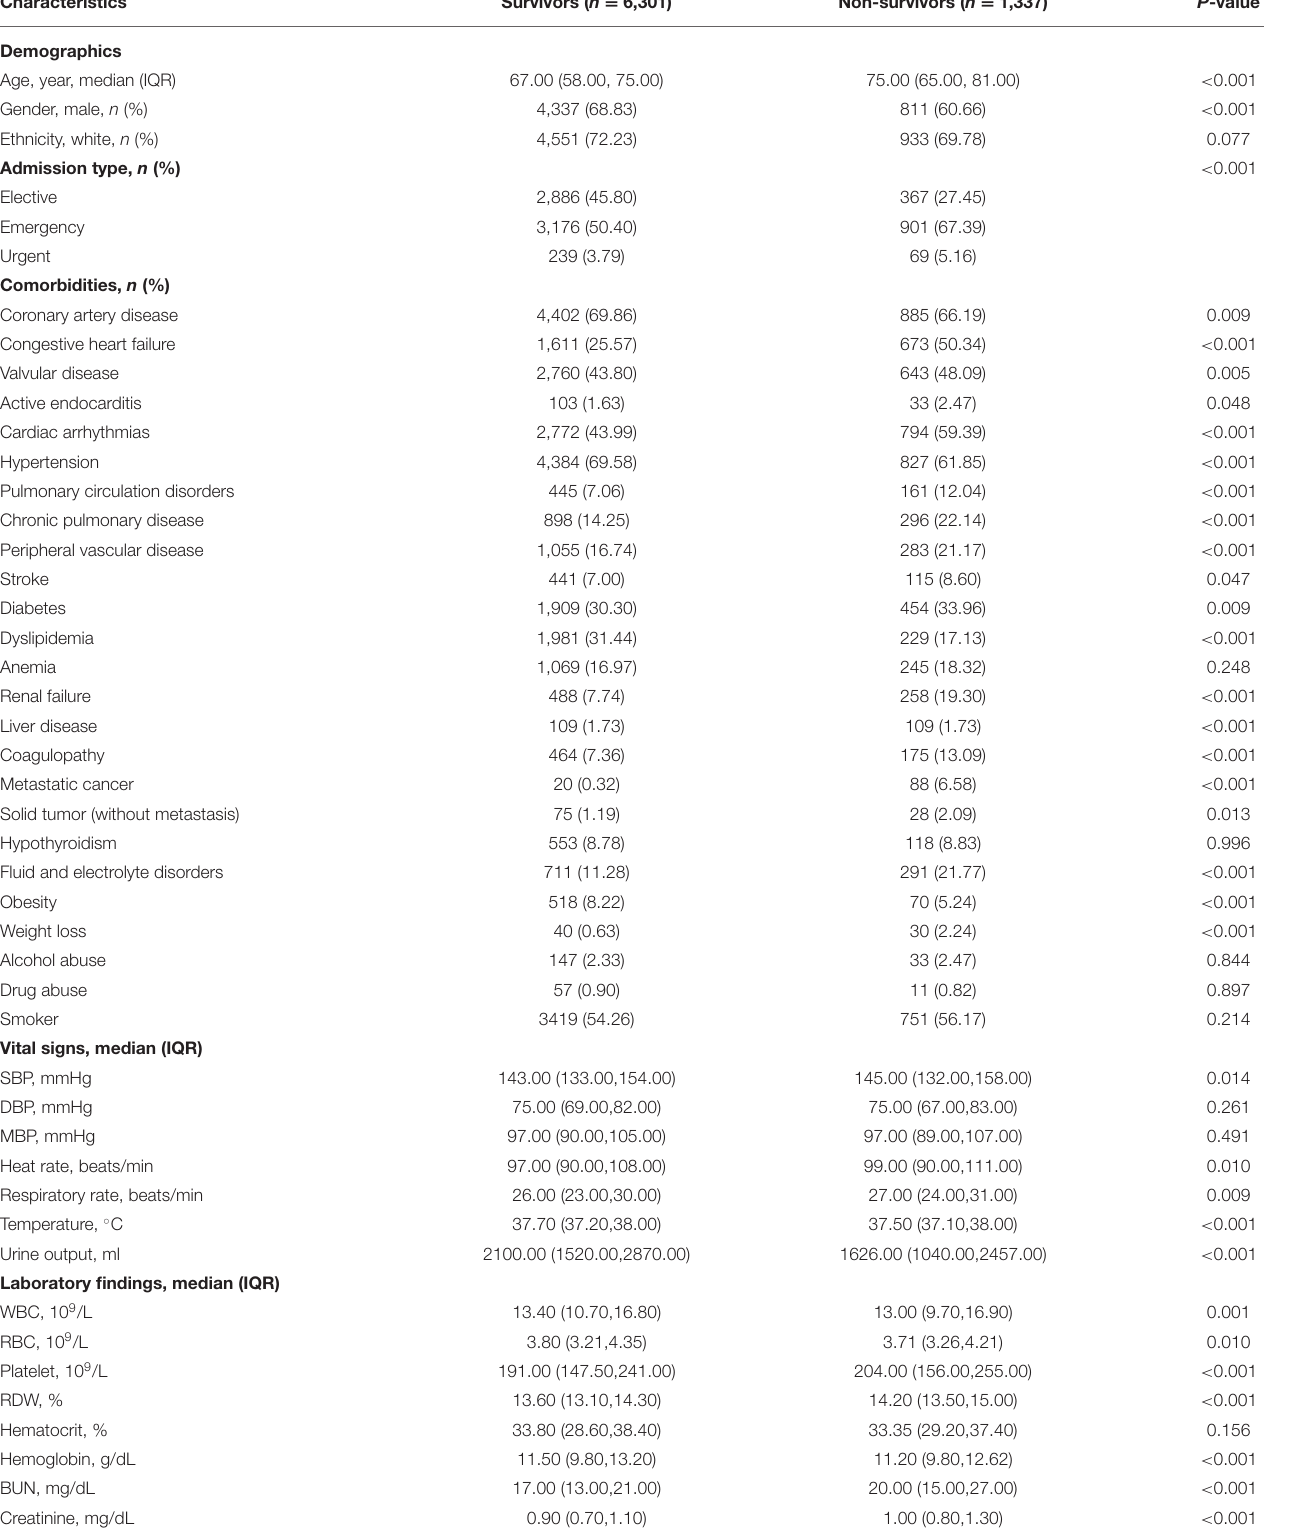
TABLE 1 | Baseline characteristics between survivors and